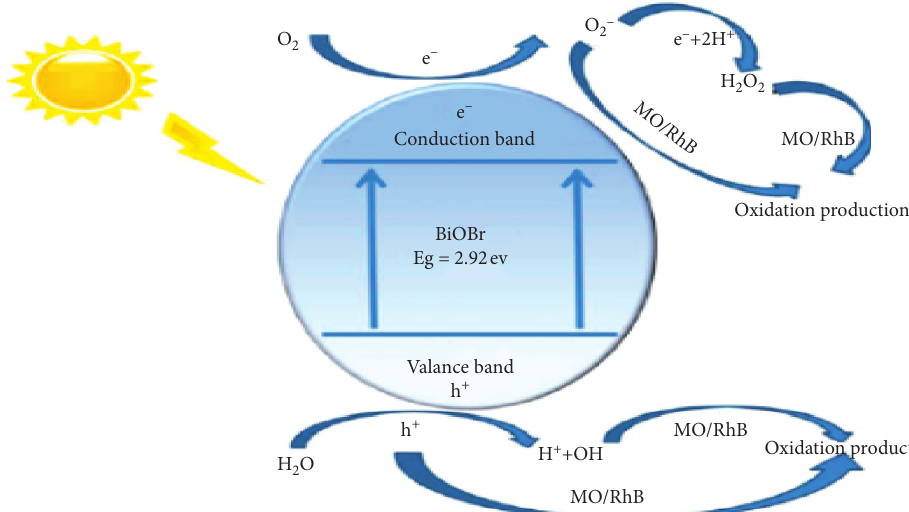
Figure 13: Schematics of photodegradation of dyes in solar irradiation